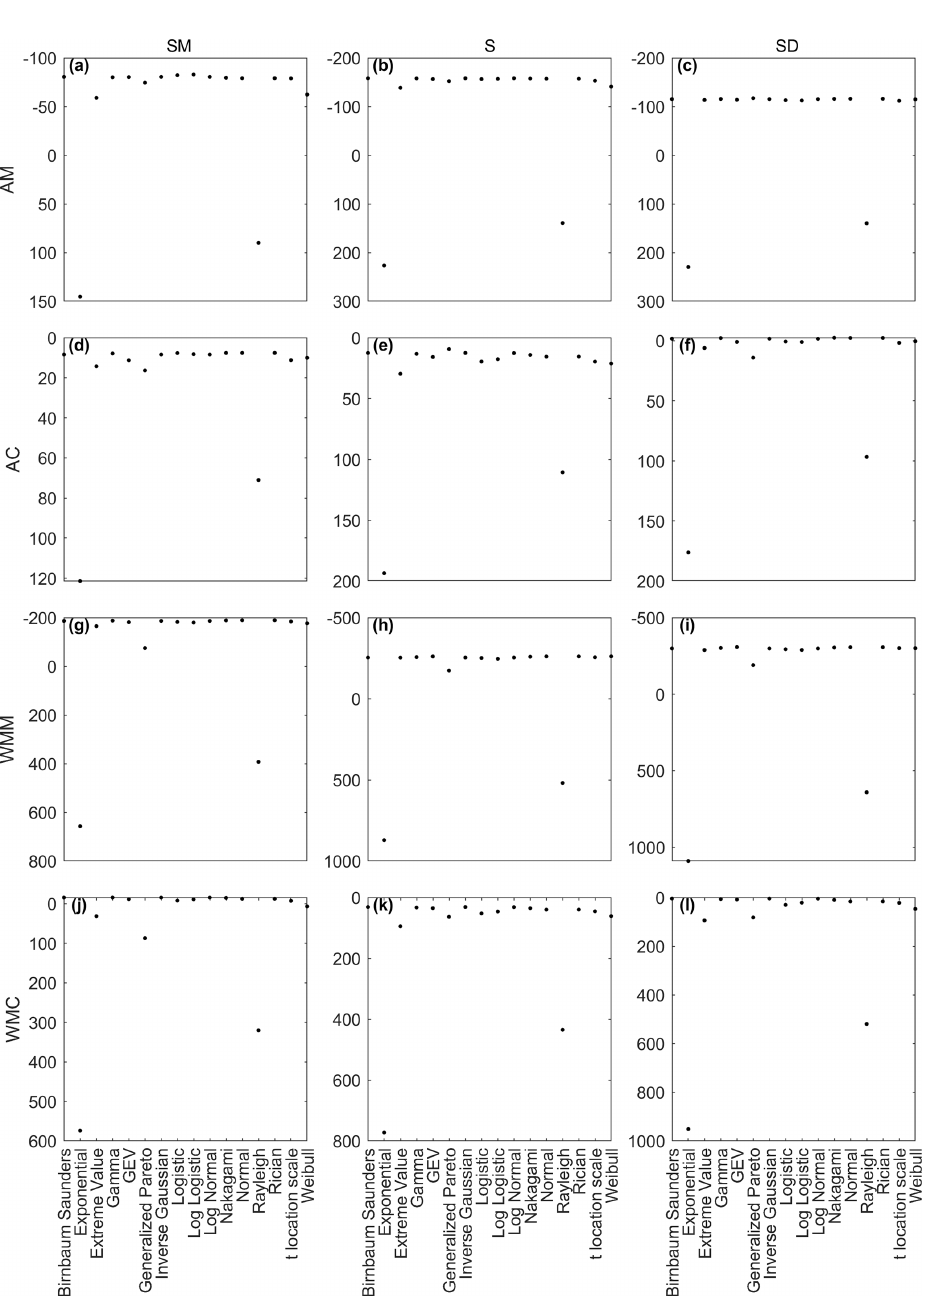
Figure A1. Marginal OWL BIC values per fitted copula for Santa Monica (left column), Sunset (middle column), and San Diego (right column) using annual maximum (a, b, c) , annual coinciding (d, e, f) , wet-season monthly maximum (g, h, i) , and wet-season monthly coinciding (j, k, l) . The y axis is oriented to display best BIC (top) to worse BIC